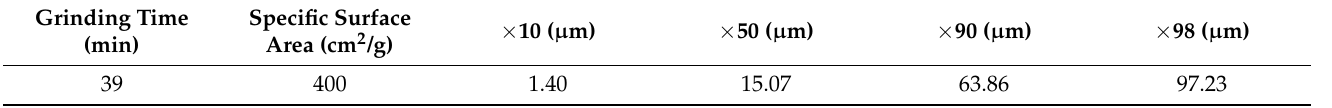
Table 3. Particle size distribution of ground